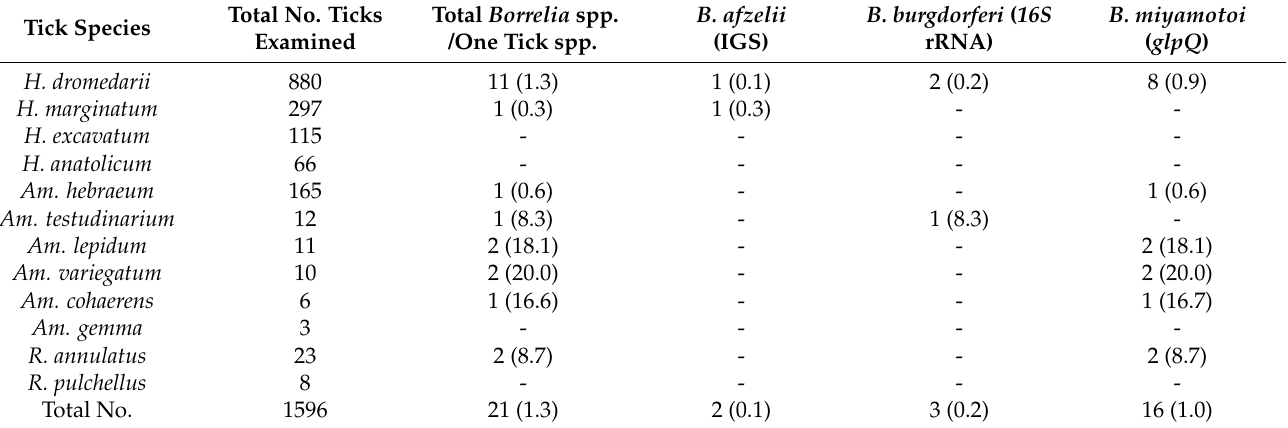
Table 4. The prevalence of Borrelia spp., B. burgdorferi, B. miyamotoi and B. afzelii among the tick